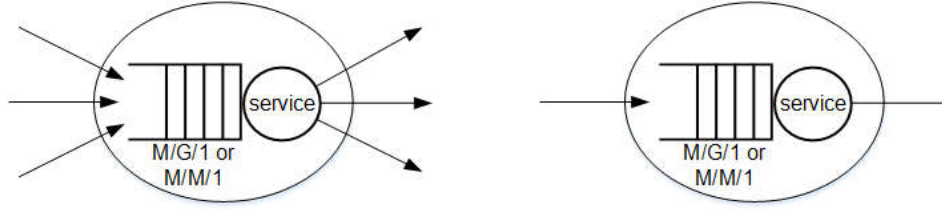
Figure 3. Model of CSCF servers, RACF C1, RACF C2 ( left ) and links ( right ). by UE 1 and UE 2 (Figure 1) are not considered in calculations of these